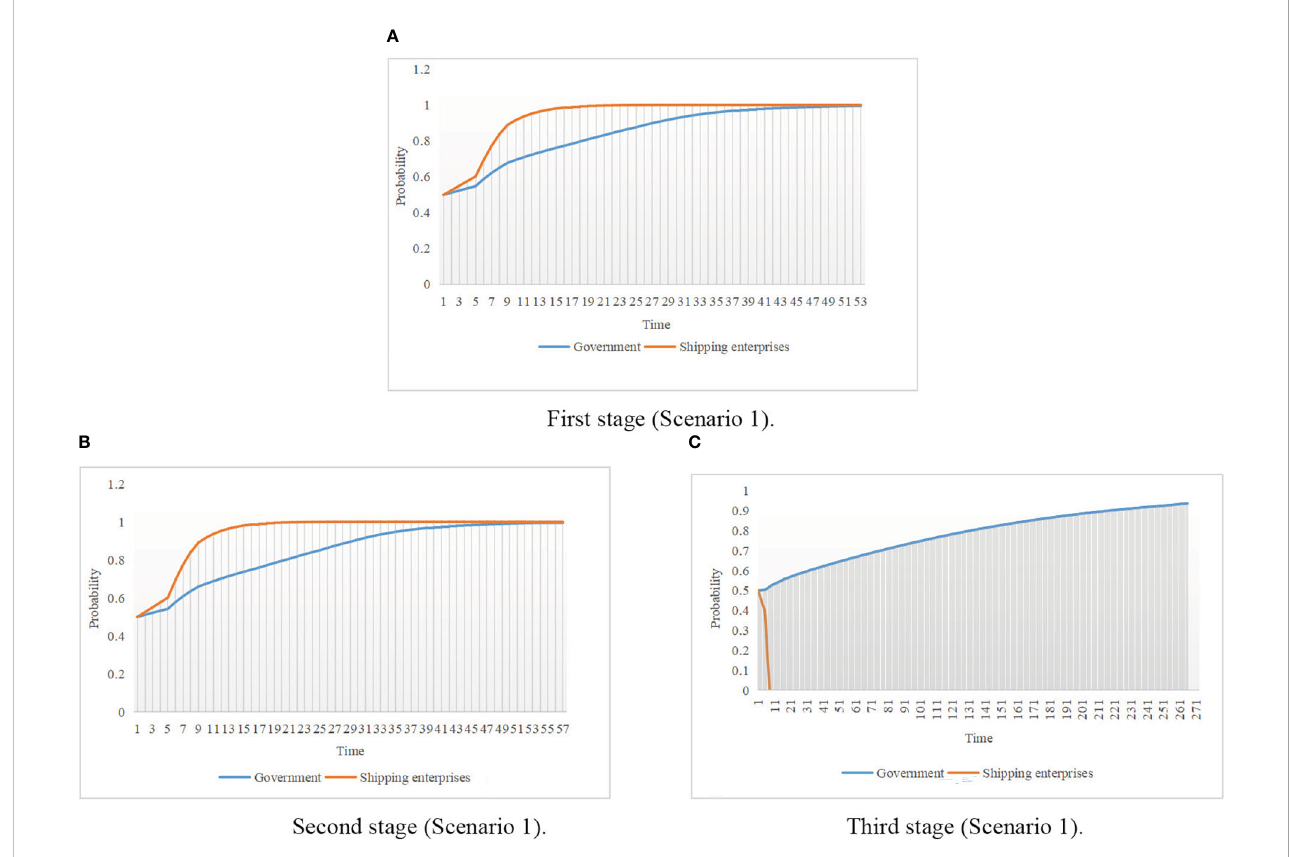
FIGURE 4 Evolutionary path of both sides (Scenario